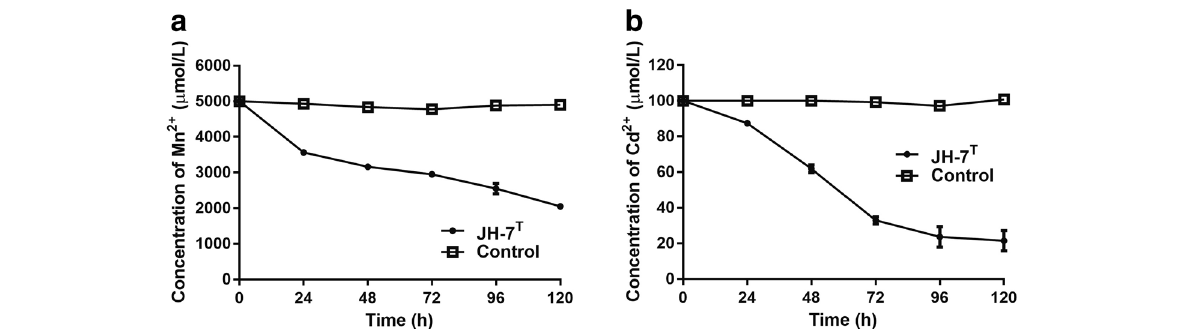
Fig. 3 Mn 2+ and Cd 2+ removed by P. manganicus JH-7 T . Control stands for null LB medium. Strain JH-7 T was incubated until OD 600 reach 1.0, and